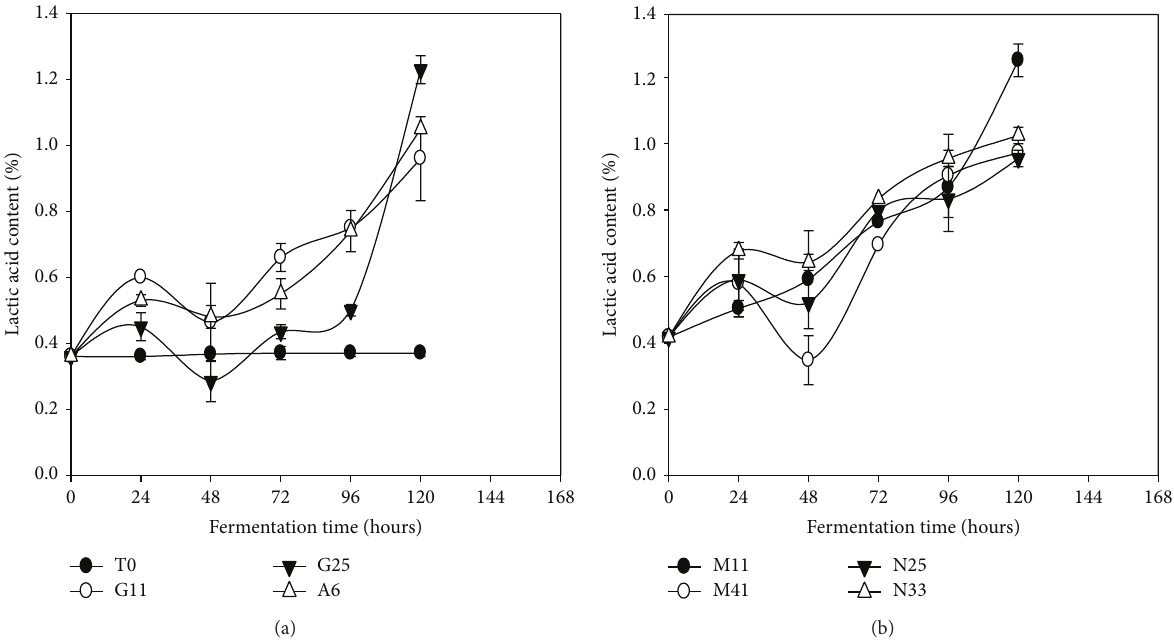
Figure 3: Evolution of the Lactic acid content in the Kutukutu during fermentation by the various LAB at 25 ∘ C (T0 = control; G11 = L. brevis G11; G25 = L. brevis G25; A6 = L. plantarum A6; M11 = L. buchneri M1; M41 = L. cellobiosus M41; N33 = L. fermentum N33; N25 = L. fermentum